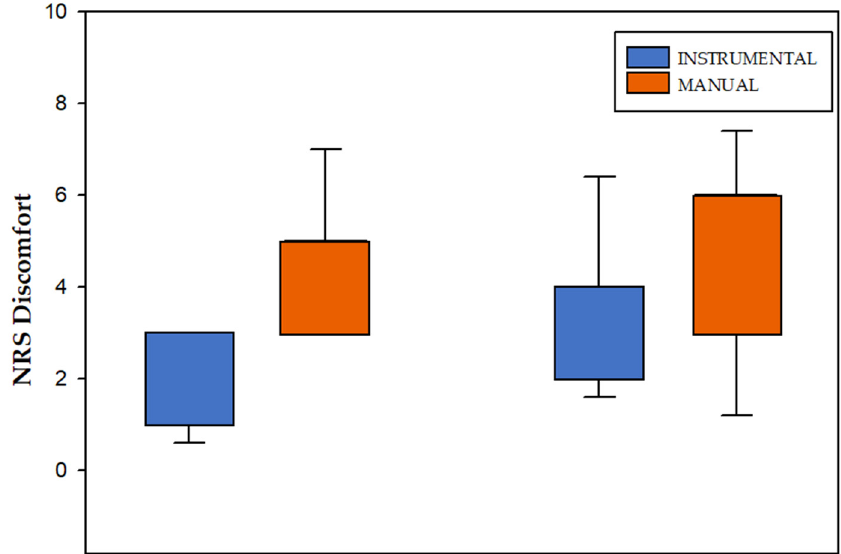
Figure 4. NRS Discomfort questionnaire. NRS: Numeric Rating Scale.